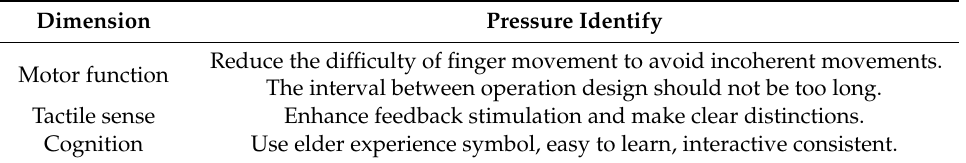
Table 1. Key points of interactive action design.